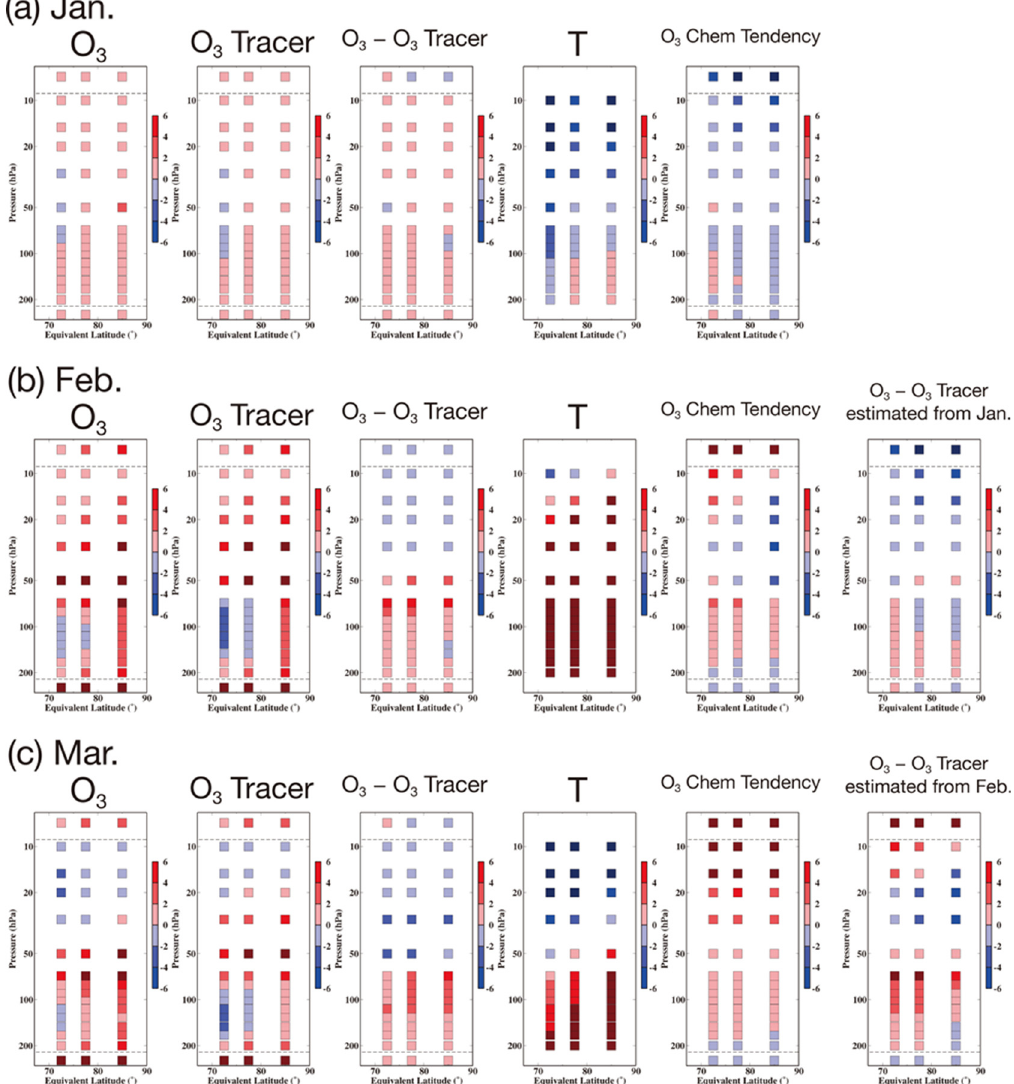
Figure 12. Same as Figure 8 but for the partial column anomaly in